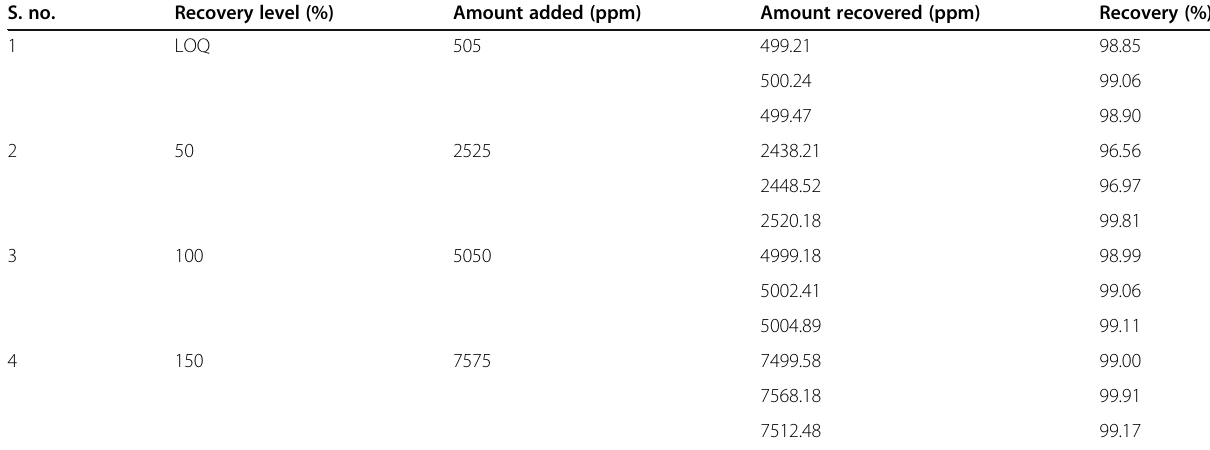
Table 14 Results of recovery study for ethylacetate S. no.